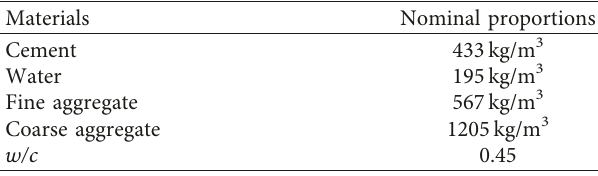
Table 1: Mixture proportions of the